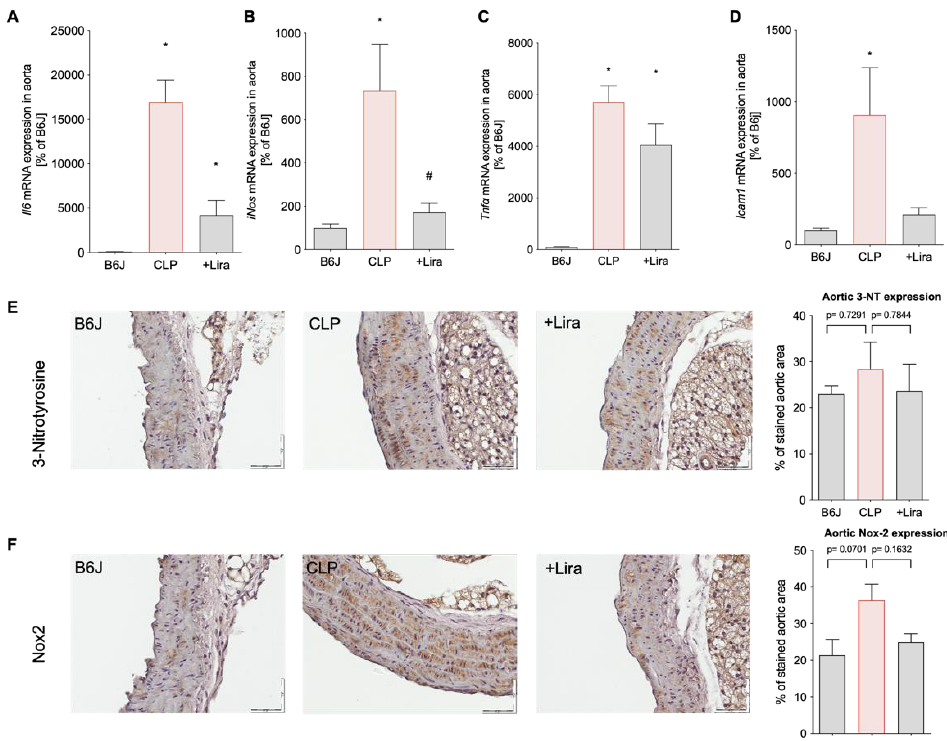
Figure 5. Treatment with the GLP-1 receptor agonist liraglutide suppresses CLP-induced vascular inflammation in polymicrobial septic mice. Aortic gene expression levels of ( A ) interleukin 6 ( Il6 ), ( B ) inducible nitric oxide synthase ( iNos ), ( C ) tumor necrosis factor alpha ( Tnfα ) and ( D ) intercellular adhesion molecule-1 ( Icam1 ) were measured by quantitative RT-PCR in aortic tissue. ( E , F ) Abundance of 3-NT-positive proteins and Nox2 protein expression in the aorta was determined by immunohistochemistry. Representative immunohistochemical images are shown next to the densitometric quantification. Magnification of 40 and scale bar of 50 μm. Data are the mean ± SEM of 3 individual samples (each pooled from 3 to 4 mice) ( A – D ) or 3 individual animals ( E , F ). * p < 0.05 vs. B6J; # p < 0.05 vs. CLP.